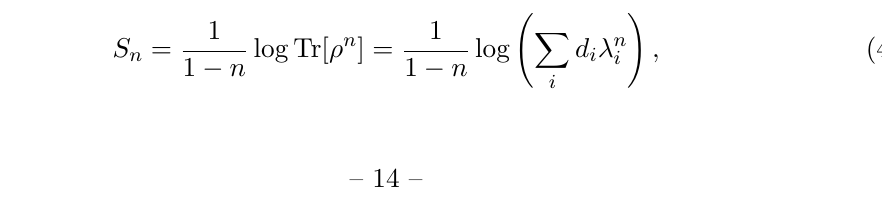
Figure 3 . The Rényi entropies as a function of n for different values of α (AdS 5 ). The dashed line is for the SAdS case, and the blue line is for α = 2 / 5 √ at n = 1 (for all α 6 = 2 / 3 ), where the second derivative has discontinuity. When 2 / a zeroth-order phase transition of black holes leads to discontinuity of Rényi entropies at n or